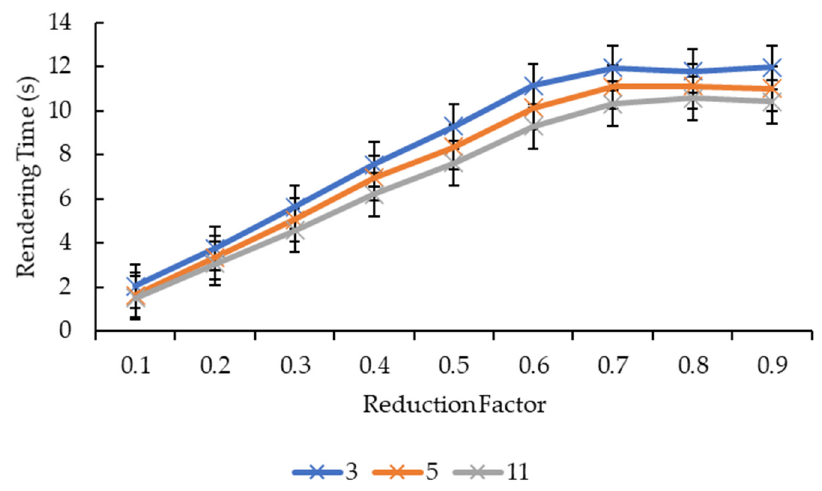
Figure 12. Graph of rendering time against reduction factor for convolution kernel box.